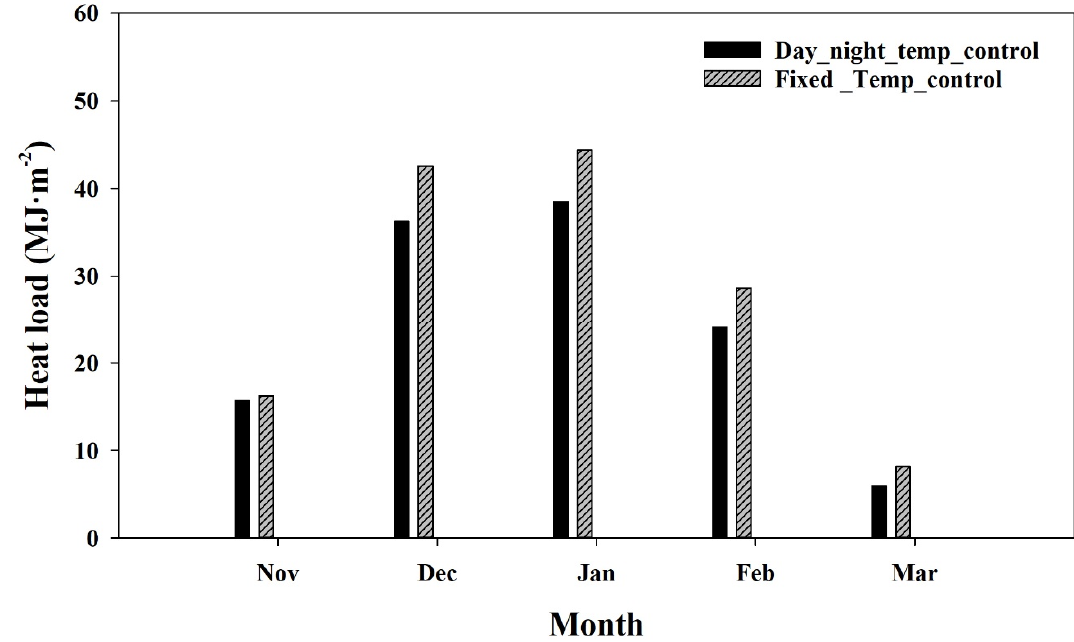
Figure 14. Monthly day- and nighttime heating setpoint effects on the heating load of the greenhouse. Table 7. Detail of temperature control used in Figure 14.